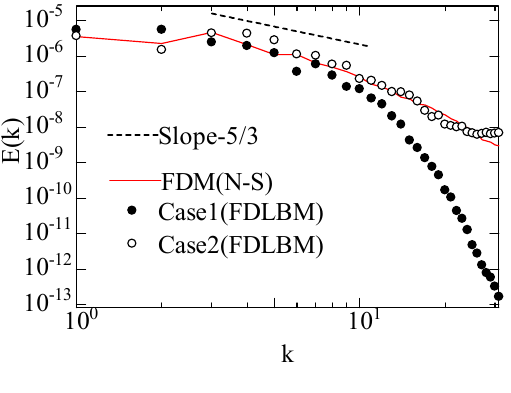
Fig. 3 Energy spectra with the DS Model (time step =